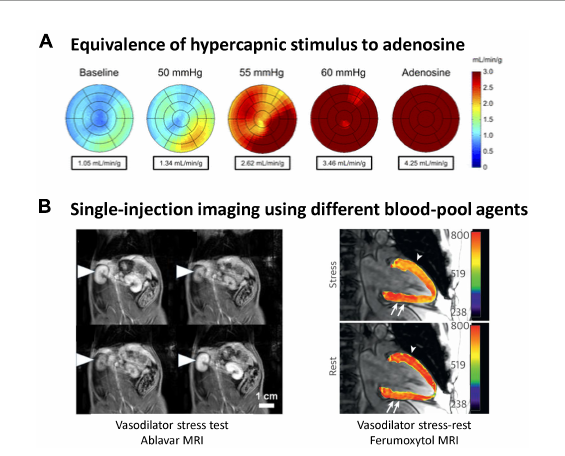
FIGURE3 Illustration of hypercapnic vasoactive stimulus and single-injection, steady-state blood-pool imaging assessment of microvascular response. (A) Myocardial perfusion maps show the equivalency of gas challenge vs. pharmacological agents for inducing vasodilation. Global myocardial perfusion is shown in a representative subject at baseline, during hypercapnic stimuli, and during adenosine stress [this research was originally published in Pelletier-Galarneau et al. (9)]. (B) Blood-pool steady-state imaging for the assessment of microvascular reactivity. (Left) Vasodilation and vasoconstriction induced by a succession of hypercapnic maneuvers on a rat administered Ablavar. On T1-weighted images, the microvasculature of the renal cortex is seen to constrict (low contrast) on exposure to 20% CO 2 but rapidly vasodilate (bright contrast) upon return to 5% CO 2 . [This research was originally published in Ganesh et al. (6). (Right) A patient with progressive angina presents a large, reversible inferior wall perfusion defect. Ferumoxytol-enhanced T 1 map shows rest hypoperfusion in the inferior wall (arrows). At peak stress, ferumoxytol-enhanced T 1 reactivity is 6% in the hypoperfused inferior wall (arrows) and 14% in the proximal anterior wall (arrowhead, net difference of 20%) [this research was originally published in Nguyen et al.